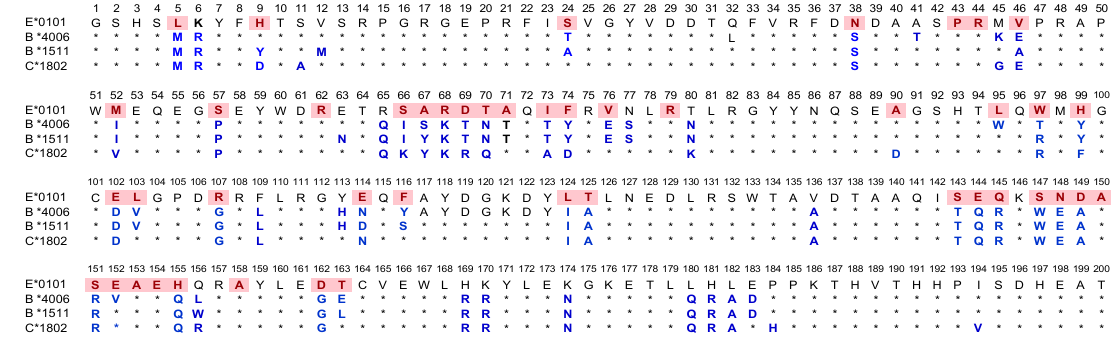
Figure 5. The amino acid sequences of HLA-E compared with the unique B (B*4006, B*1511) or C (C*1802) alleles recognized by a few HLA-E R or HLA-E G mAbs. The asterix in the figure illustrates amino acids, and sequences shared between HLA-E and B*4006 or B*1511 or C*1802.